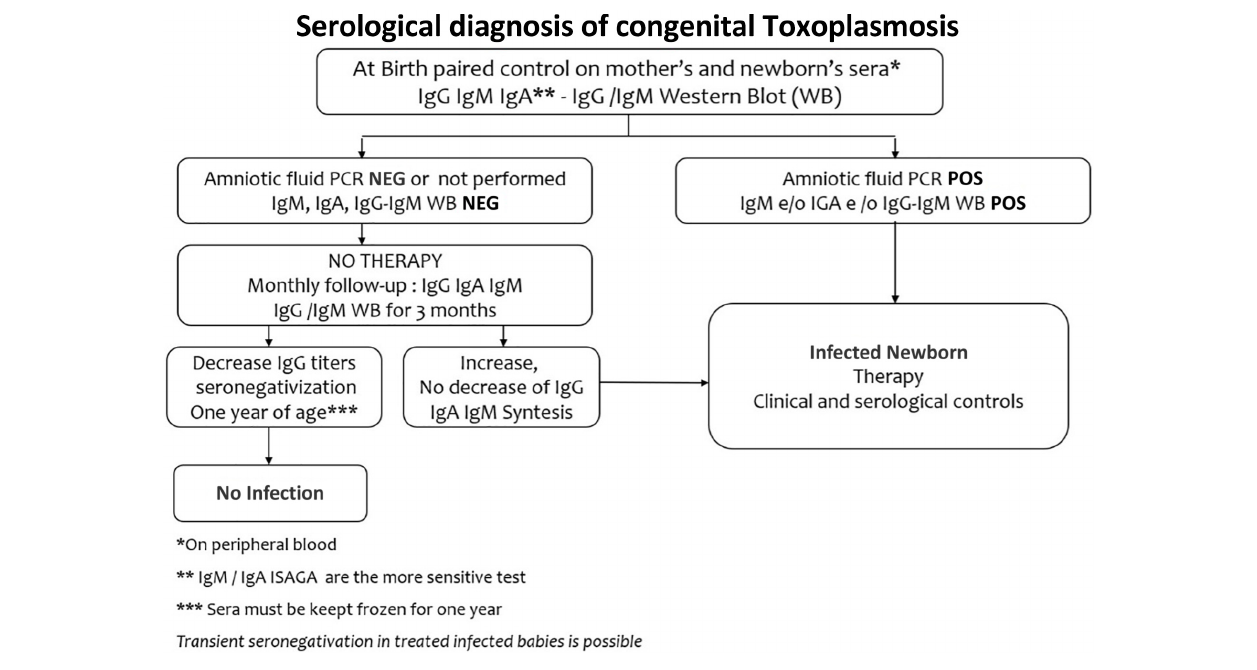
FIGURE 3 | Serological screening of congenital